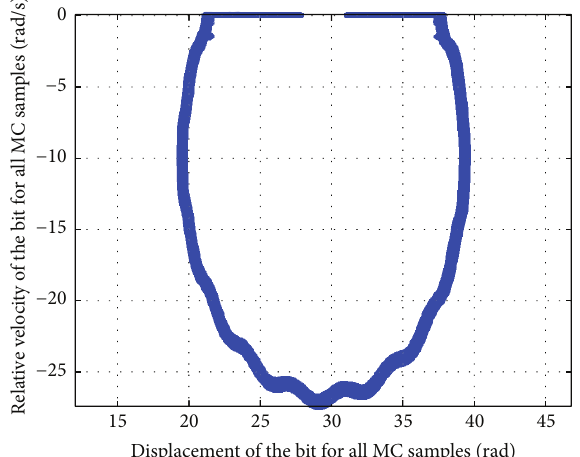
Figure 7: Phase plane for all MC samples between two representa- tive points (stick-slip).